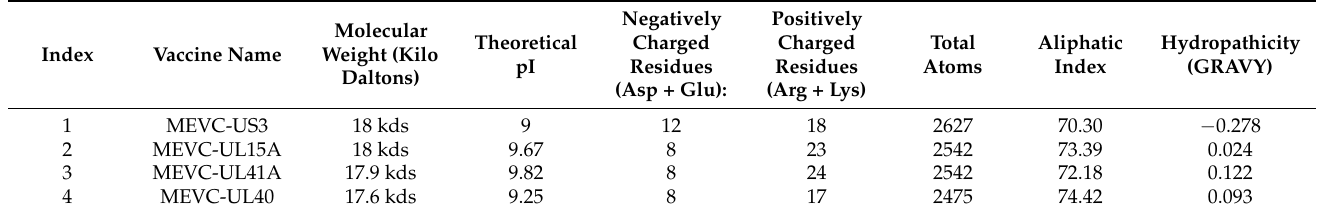
Table 3. Represents the physiochemical properties of the designed MEVCs against four target proteins of HCMV.